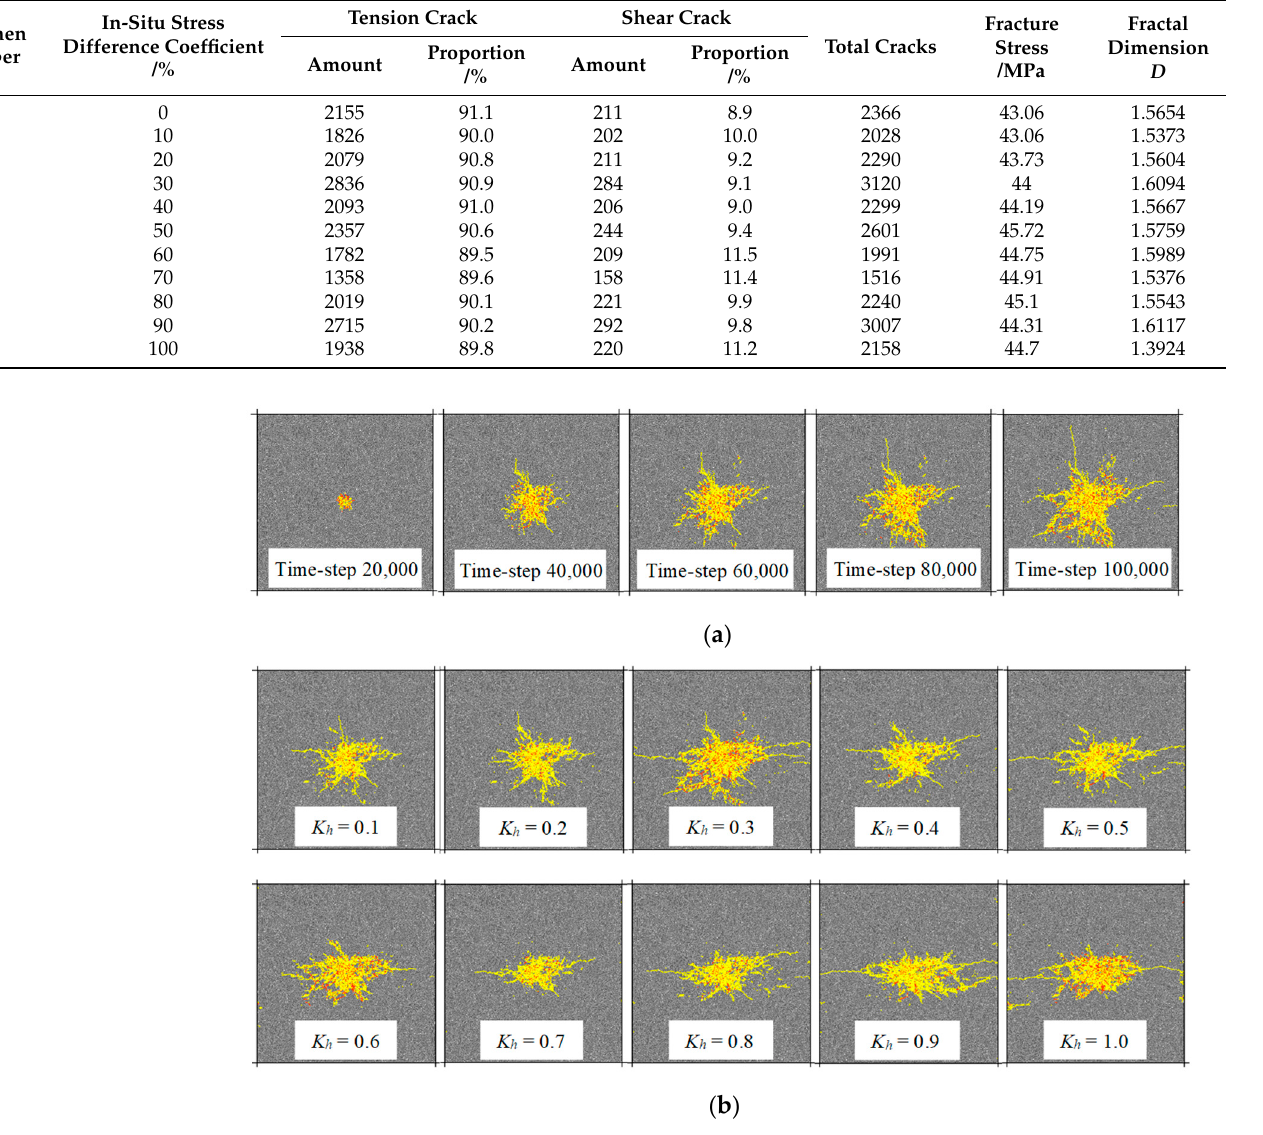
Figure 6. Fracture network morphology under different time-steps and different horizontal in-situ stress difference coefficients: ( a ) fracture network morphology at different time-steps when horizontal in-situ stress difference coefficient K h = 0.1; ( b ) fracture network morphology under different horizontal in-situ stress difference coefficients.